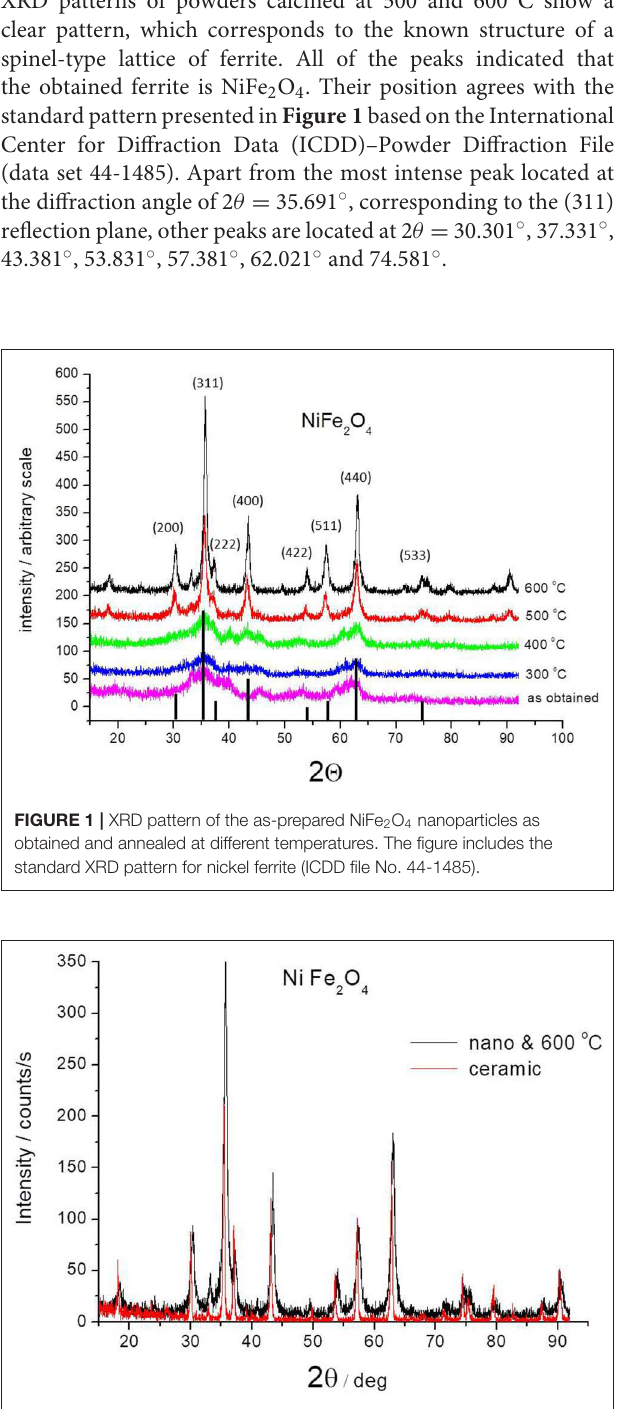
FIGURE 2 | Comparison of XRD pattern of NiFe 2 O 4 ferrites obtained by ceramic method at 1200 ◦ C or by co-precipitation method and after annealing at 600 ◦